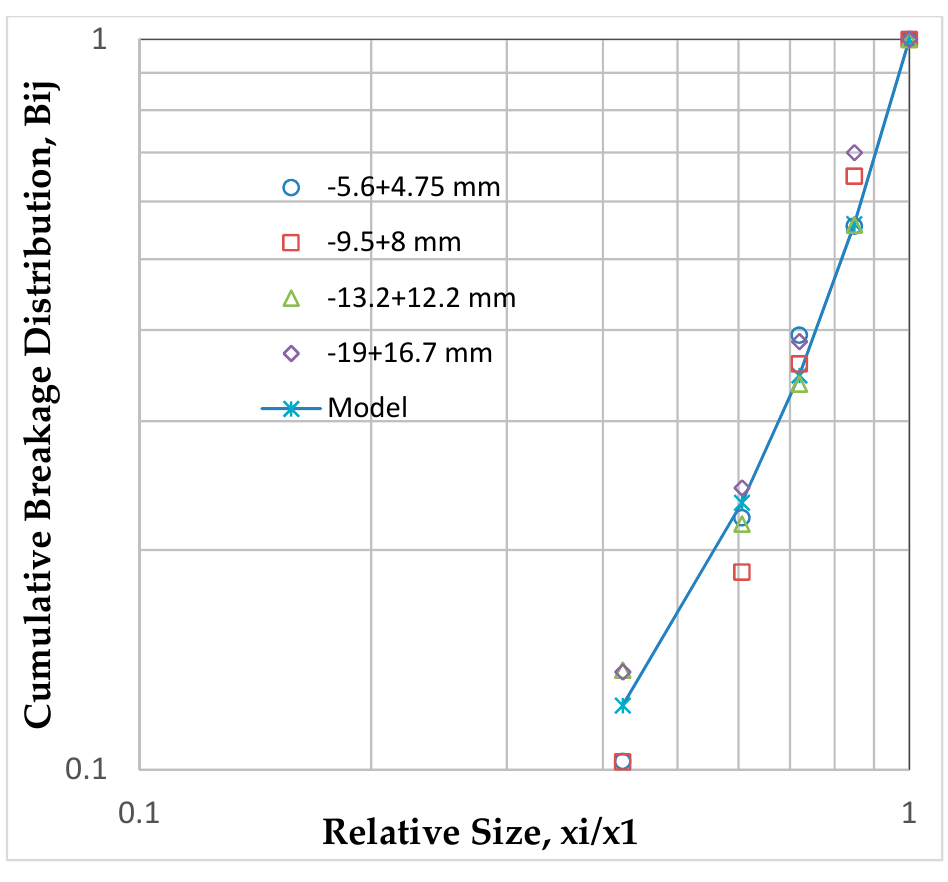
Figure 5. Breakage function for different feeds. Table 3. Breakage